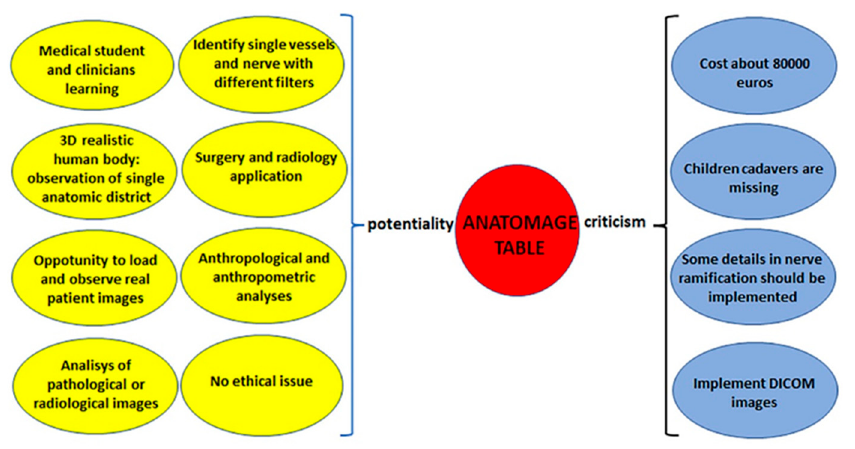
Figure 5. Anatomage Table strengths (yellow) vs. weak points (light blue).